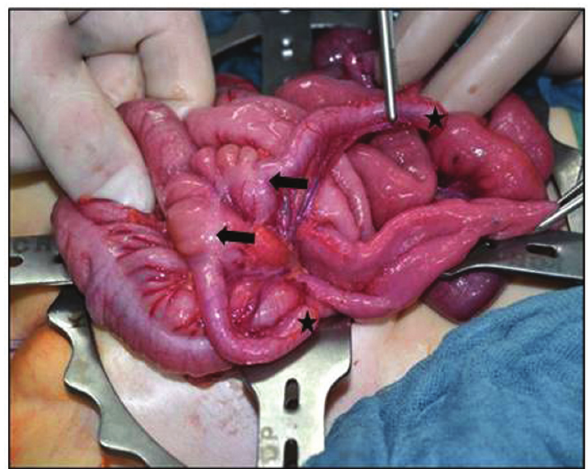
Fig. 2 Duplicated terminal ileum with a separated mesentery leading to two ceca (arrows) and appendices (asterisks).